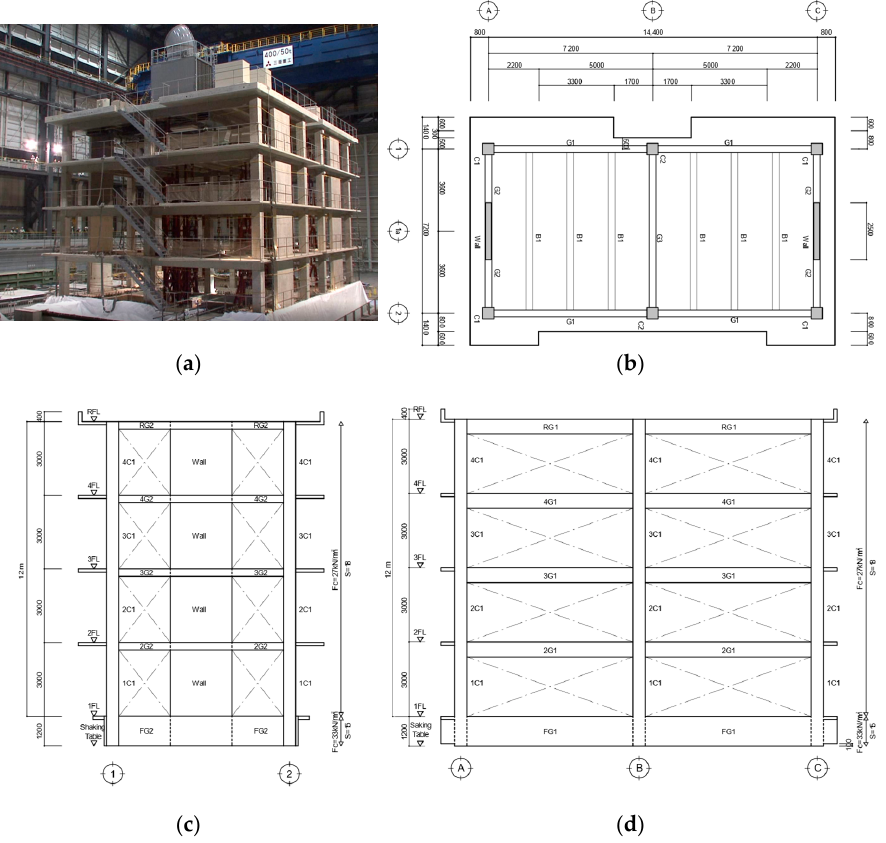
Figure 1. Configuration of test specimen and labeling of structural elements (unit: mm): ( a ) Photo of specimen installation on shake table (front: RC specimen; back: PT specimen); ( b ) plan of standard floor (second to fourth floors); ( c ) elevations of A and C frames (the shear wall frame); and ( d ) elevations of first and second frames (the moment-resisting frame).